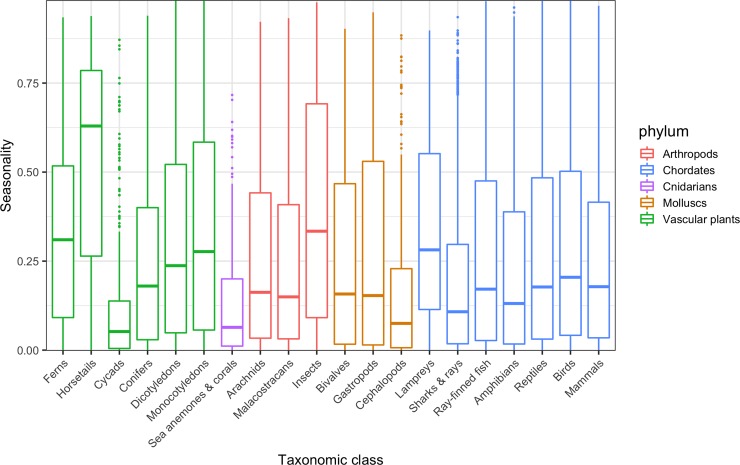
Prevalence of seasonality in Wikipedia pageviews varies across clades.Horizontal thick lines show median seasonality for species in 20 taxonomic classes in our data set that include over 100 species (n = 126,058 pages for 31,495 species). Bars indicate interquartile range, whiskers extend to 1.5× the interquartile range beyond the nearest quartile, and individual points are outliers beyond this. Seasonality is measured by the amount of variation in pageviews explained by a sinusoidal model with a single annual peak (via adjusted R2; for data used in plots, see S3 Data).